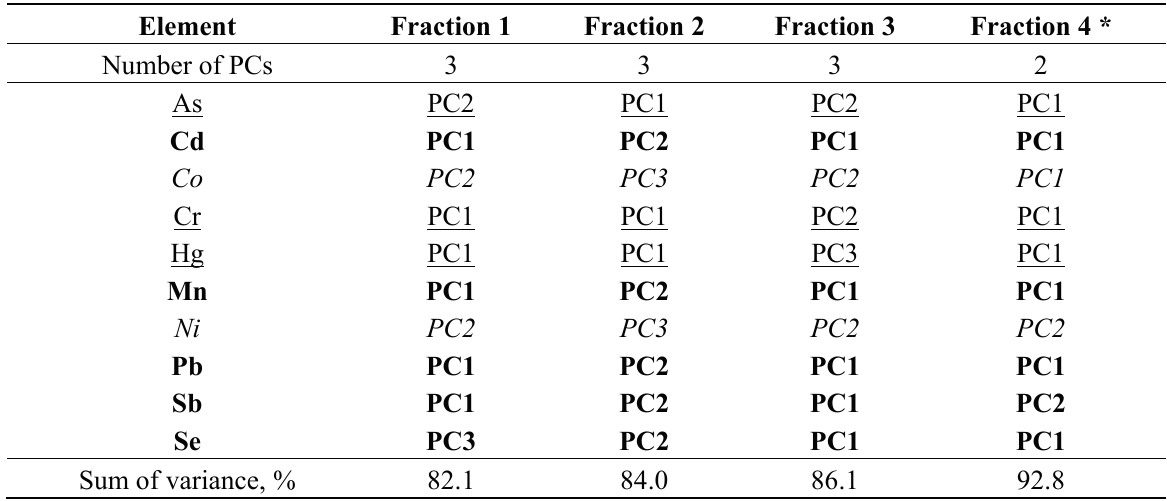
Table 5. The total explained